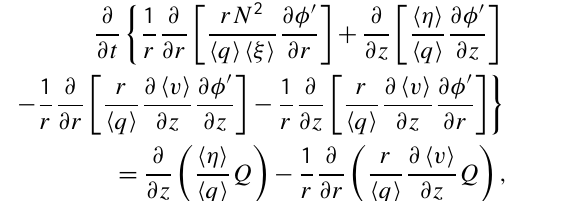
this coordinate system is that Z is nearly equal to height z